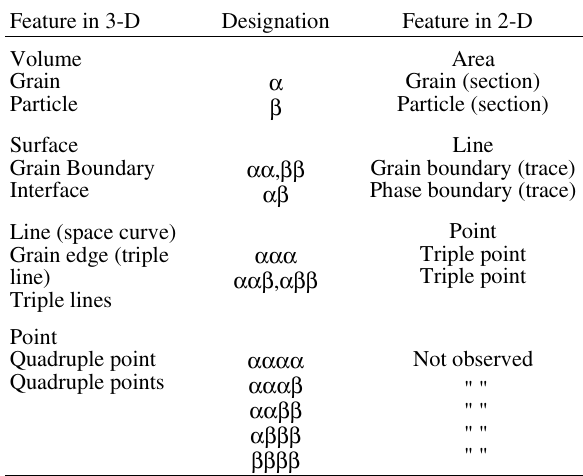
Table 2. Features you see on a section through the